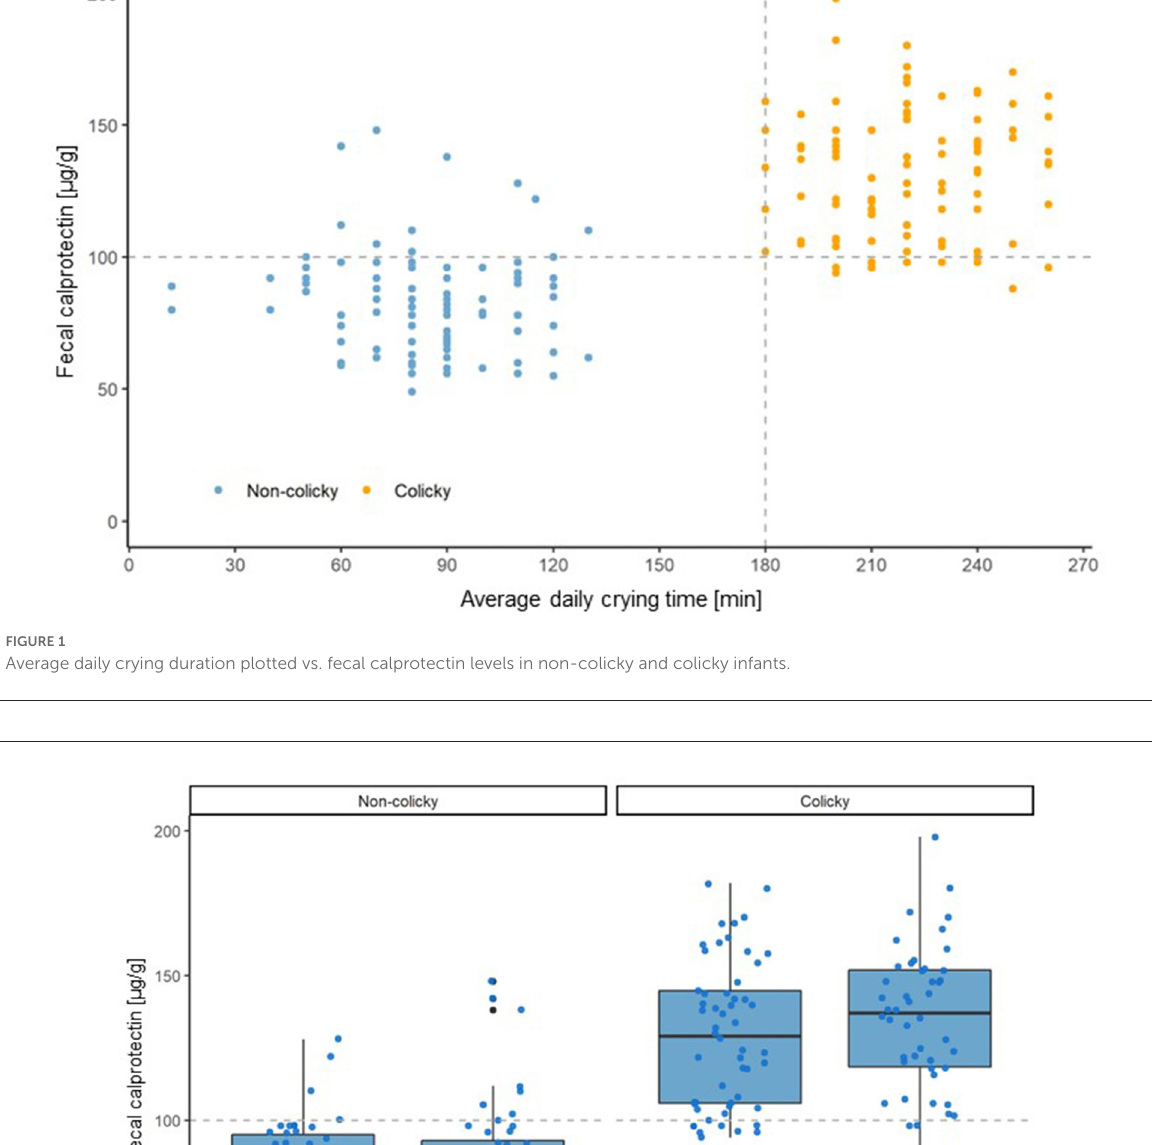
colicky status would be 13.2 and 11.2%, respectively (Figure 5). Calculating the area under the ROC curve equaled